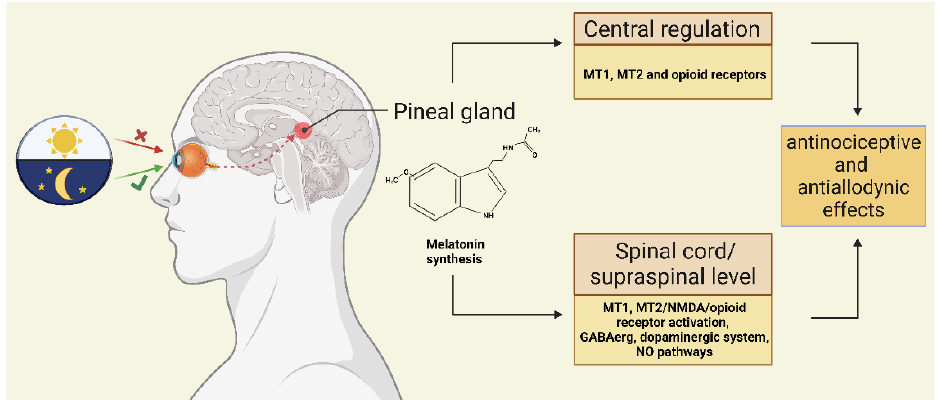
Figure 4. Melatonin synthesis and its anti-nociceptive and anti-allodynic effects. Melatonin can probably induce an anti-nociceptive effect through the regulation of MT1/MT2 receptors in the spinal cord and brain. It also interacts with other receptors such as NMDA, opioids, the dopaminergic system, the GABAergic system, and the NO pathway to exert anti-nociceptive and anti-allodynic effects. MT1/2: melatonin receptor 1/2, NMDA: N-methyl-D-aspartate, GABA: gamma-aminobutyric acid, NO: nitric oxide.